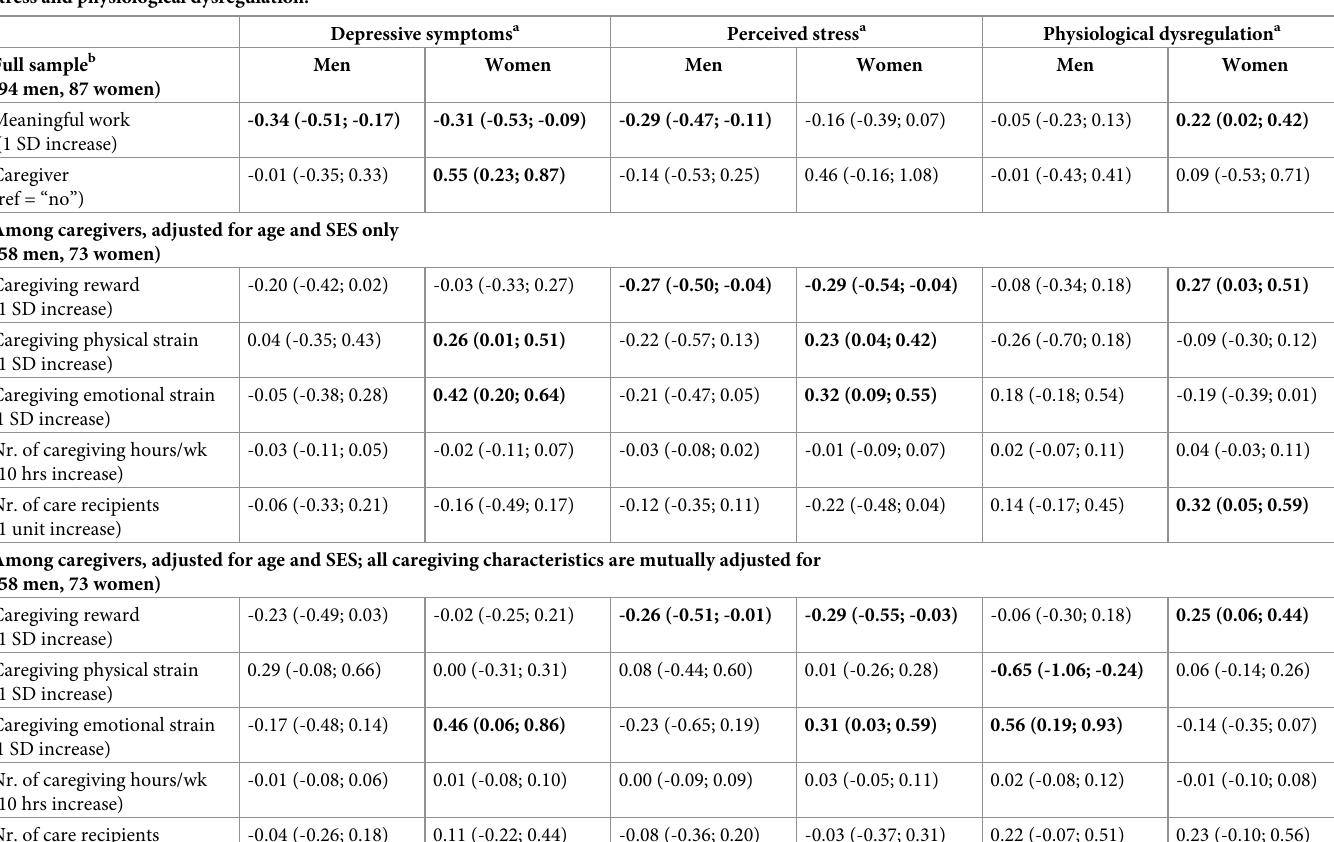
Table 3. Standardized regression coefficients and 95% CIs for the effects of meaningful work and caregiving responsibilities on depressive symptoms, perceived stress and physiological dysregulation.